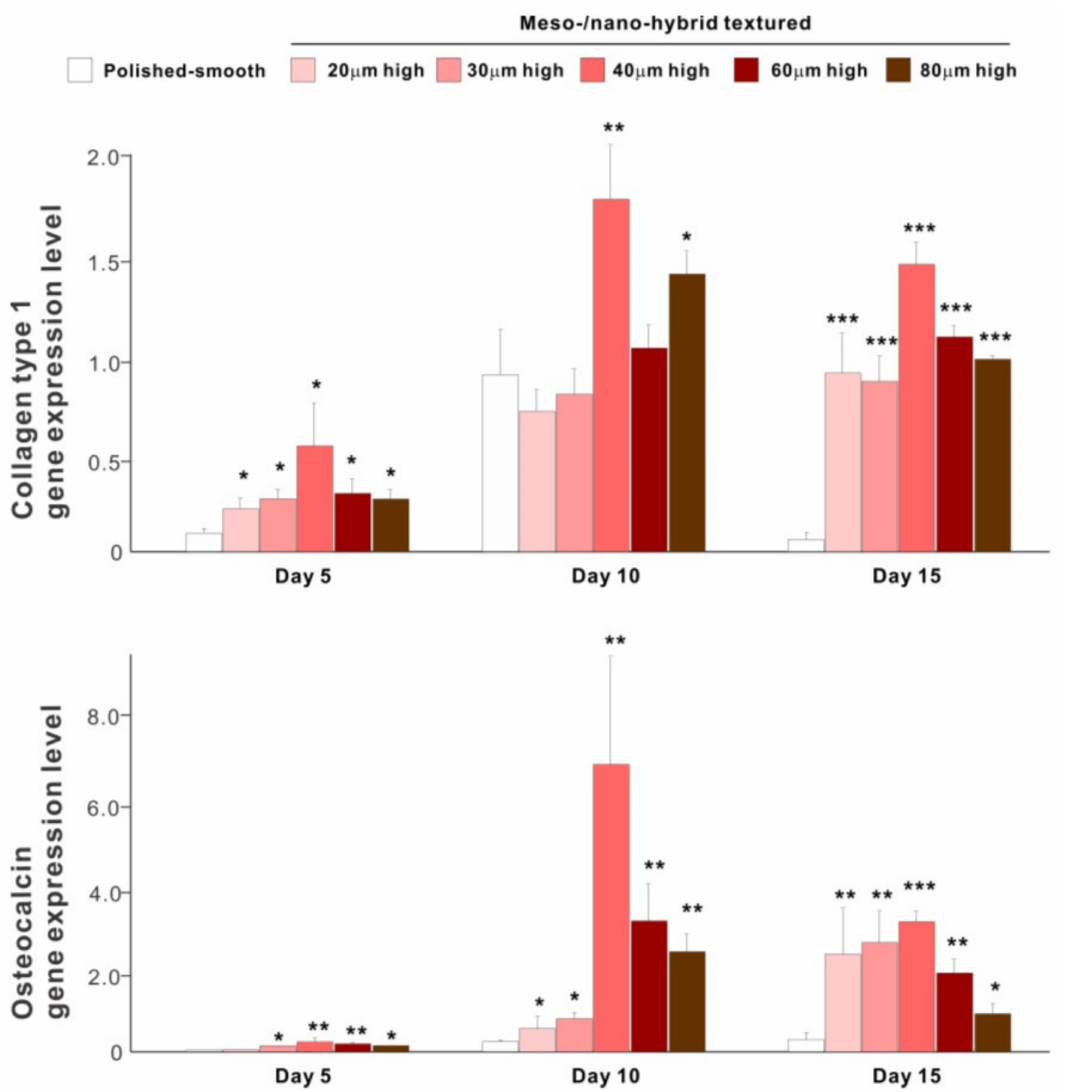
Figure 9. Osteoblastic differentiation on variously textured zirconia surfaces evaluated by real-time PCR on days 5, 10, and 15 of culture. Collagen type 1 and osteocalcin gene expression were evaluated as early- and late-stage differentiation markers, respectively. * p < 0.05, ** p < 0.01, *** p < 0.001, statistically significant difference compared with a polished